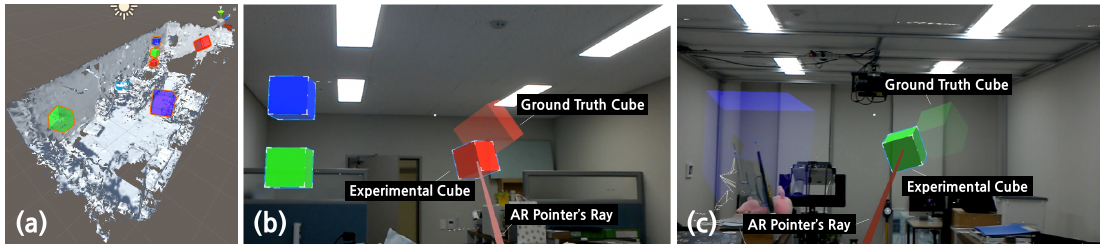
Figure 5. Experiment 2 test environment. ( a ) Demonstration room overview. ( b , c ) Docking tasks of 3D objects using AR